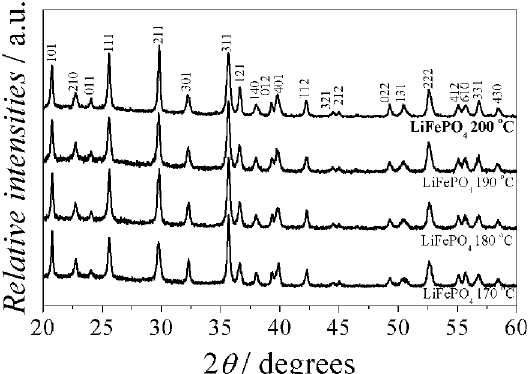
Figure 1. X-ray patterns of LiFePO 190 ºC and 200 ºC for 10 h.